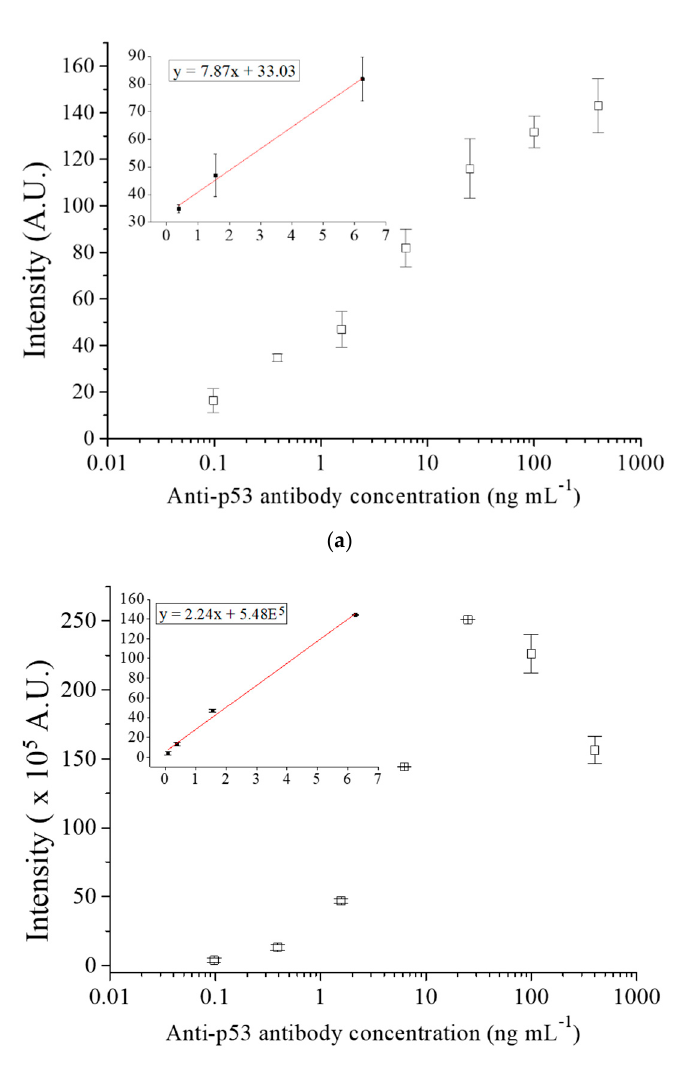
Figure 5. ( a ) The anti-p53 antibody standard curve assay in the glass capillary. The anti-p53 antibody standard solutions at various concentrations, including 400, 100, 25, 6.25, 1.56, 0.39, and 0.098 ng mL − 1 , were tested. ( b ) The anti-p53 antibody standard curve assay in the 96-well plate as a comparison to the above glass capillary method.